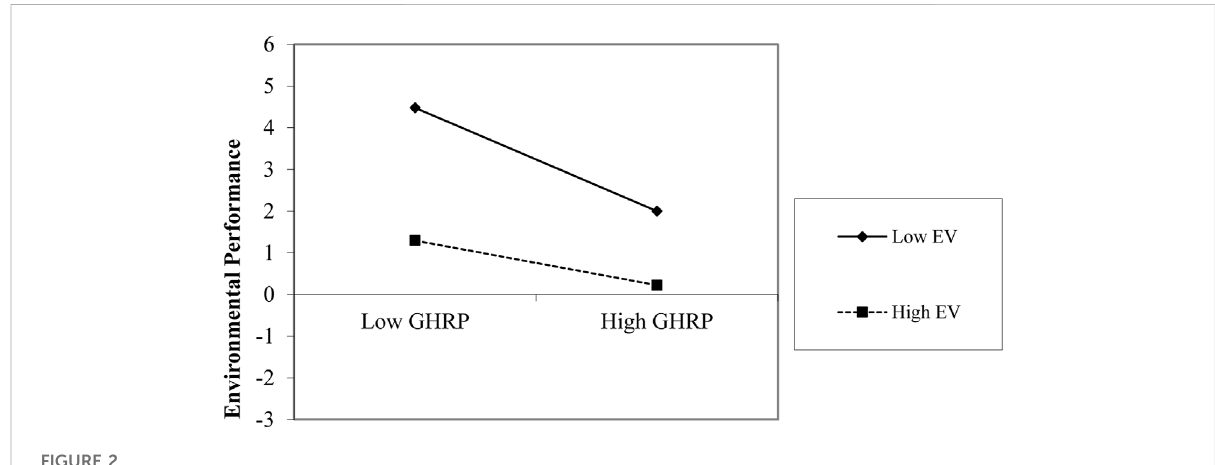
FIGURE 2 Moderation effect of environmental